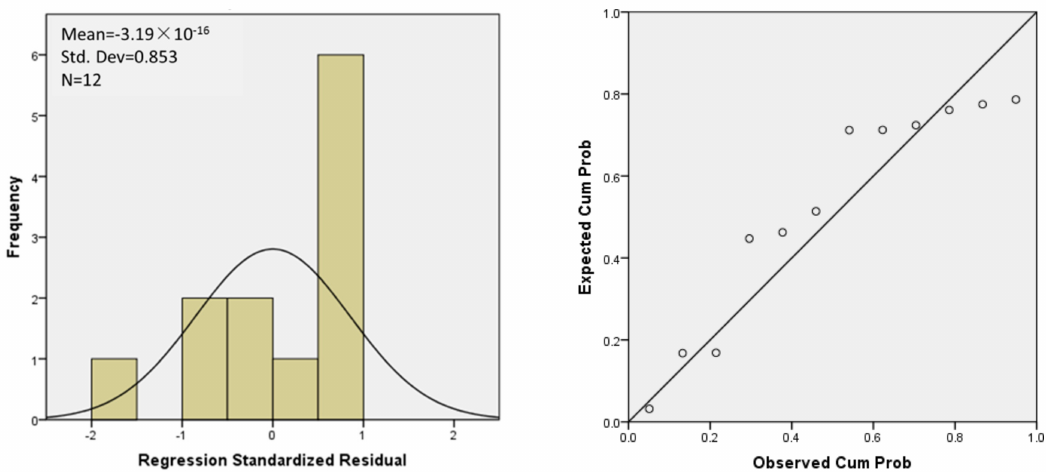
Figure 9. Residual analysis results for Froude Number Fr vs. flow rate Q , slope S and the vertical grading coefficient Ψ .